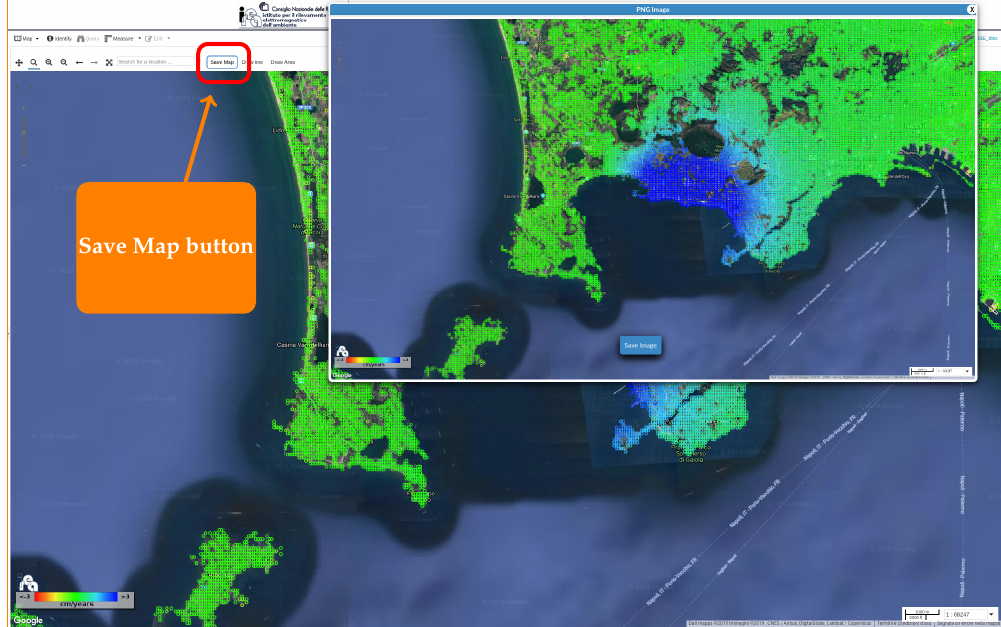
Figure 18. Example of saving as "png" format image an area visualized in GeoExplorer; highlighted in the red rectangle is the Save Map